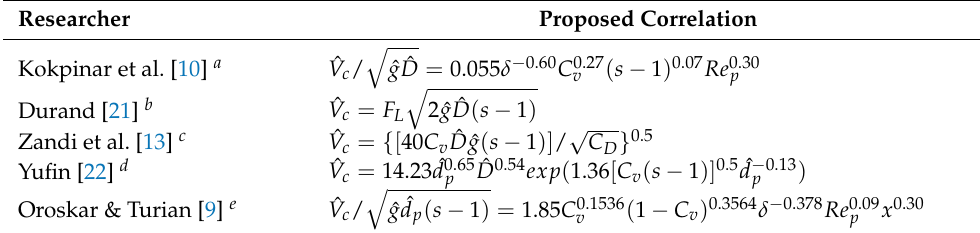
Table 1. Proposed correlations for the critical